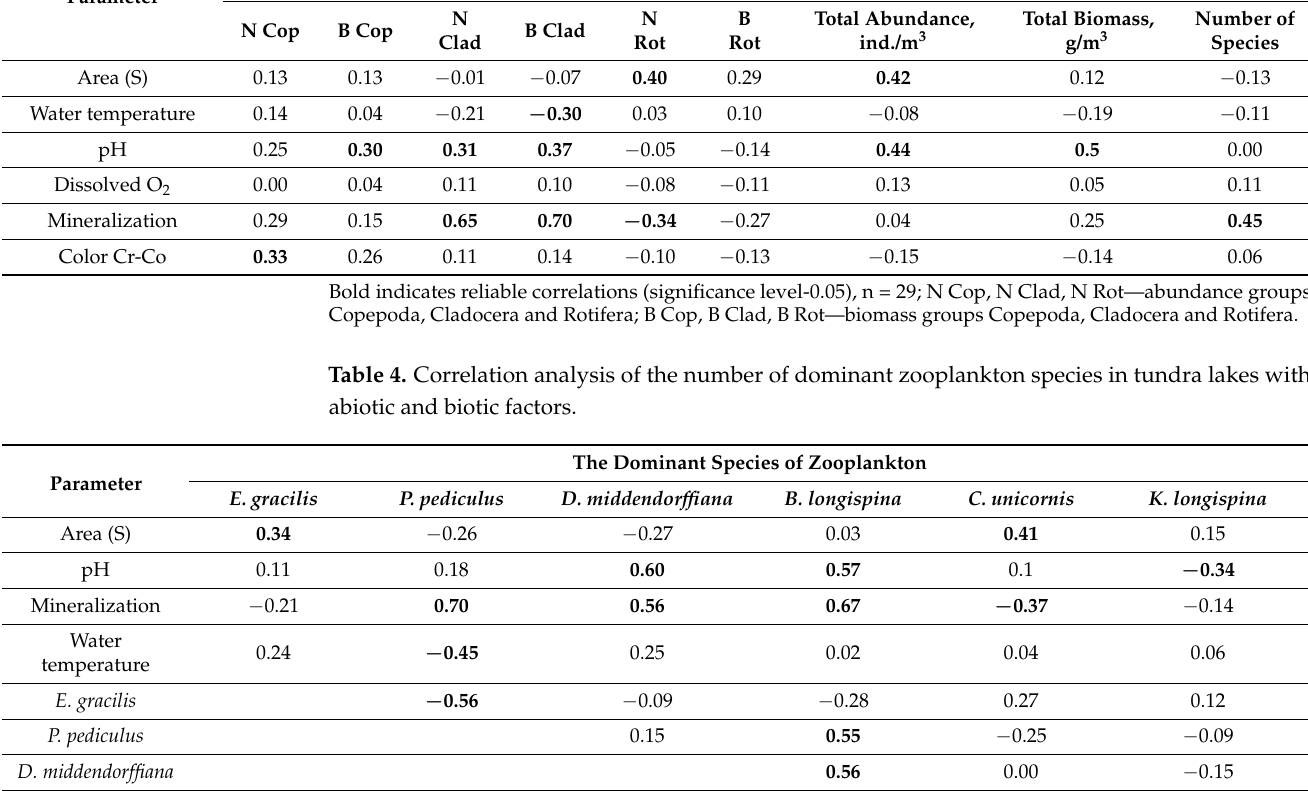
Table 3. Correlation analysis of zooplankton structural indicators with hydrological and hydrochemi- cal factors.